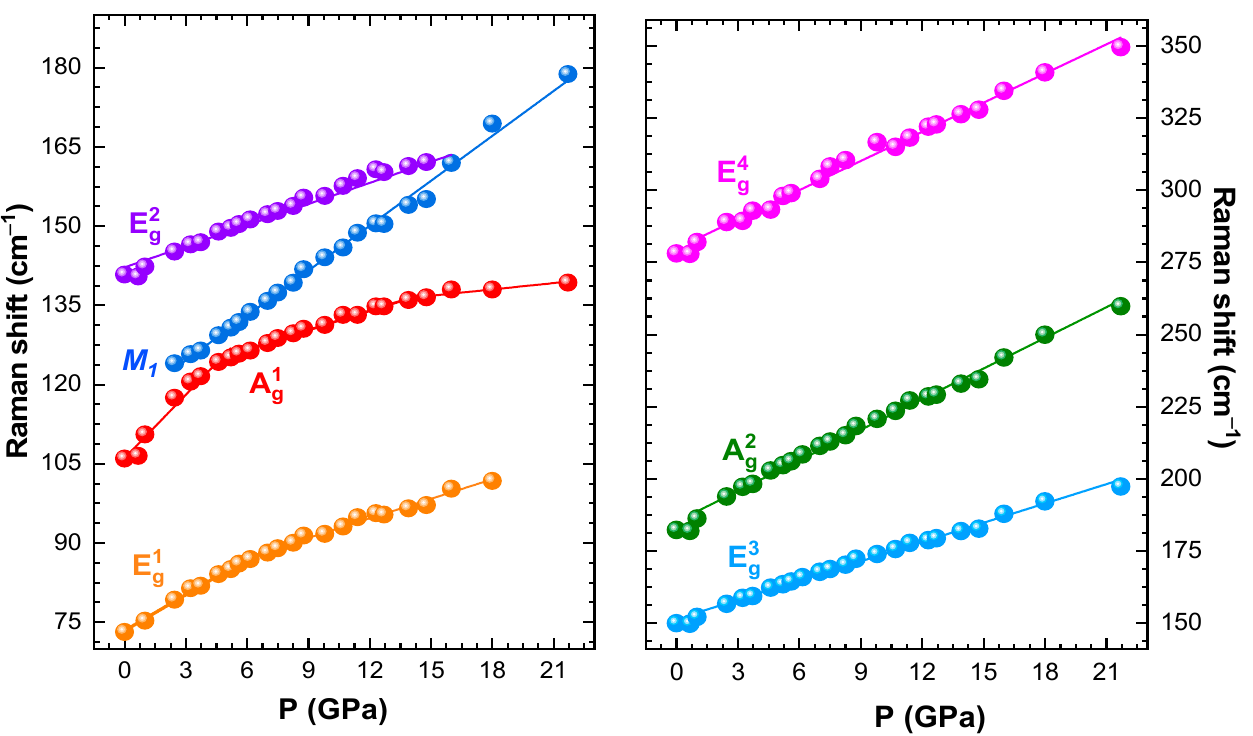
Figure 5. Pressure dependences of selected Raman shift for CrBr 3 . Solid lines are linear fits to the observed frequencies.